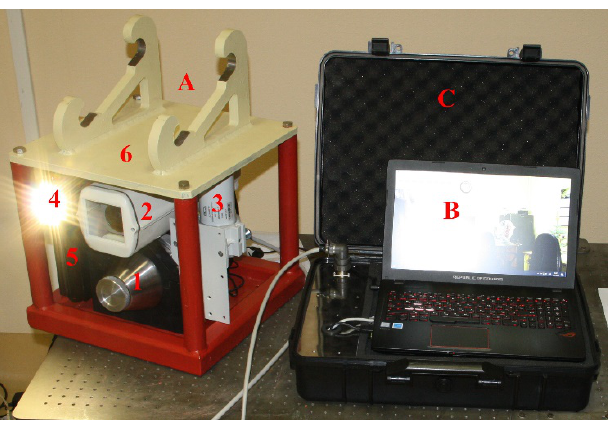
Fig.1. Photo of the “Gamma-Pioneer” system with a control computer and a protective case. The connection between the control computer and the measuring system is carried out using a USB extender and a twisted pair cable 100 meters